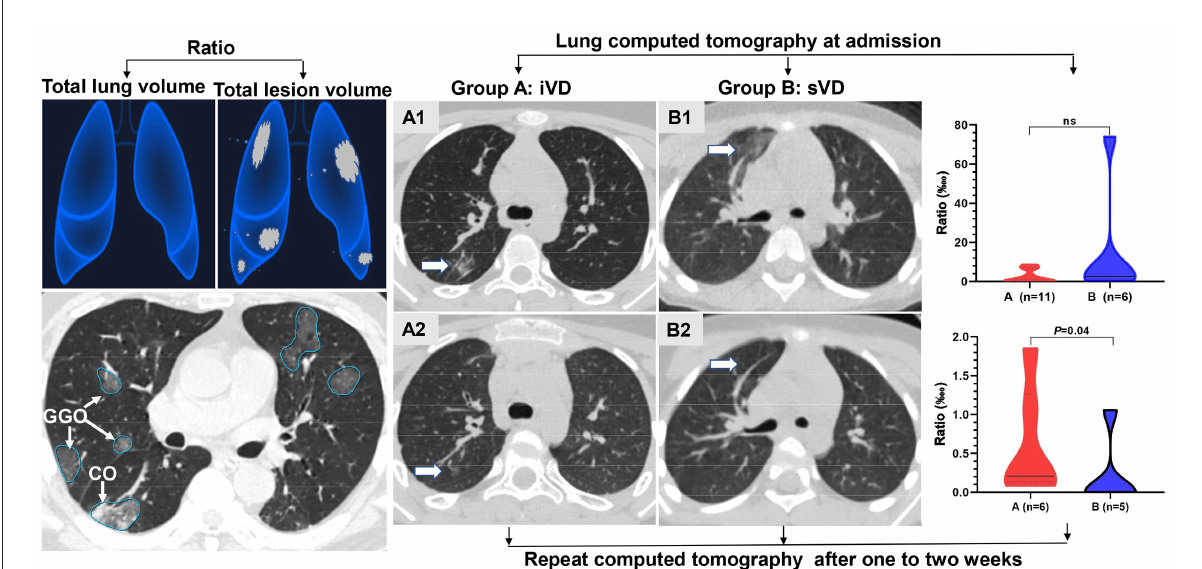
FIGURE4 The COVID-19 pneumonia lesions included ground-glass opacity (GGO), consolidation (CO), and nodular opacities were identified and measured by AI and radiologists. The differences in the ratio of total lesion volume to total lung volume in computed tomography at admission (not significant) and 1–2 weeks later ( P = 0.04) were compared between the iVD (A) and sVD (B)